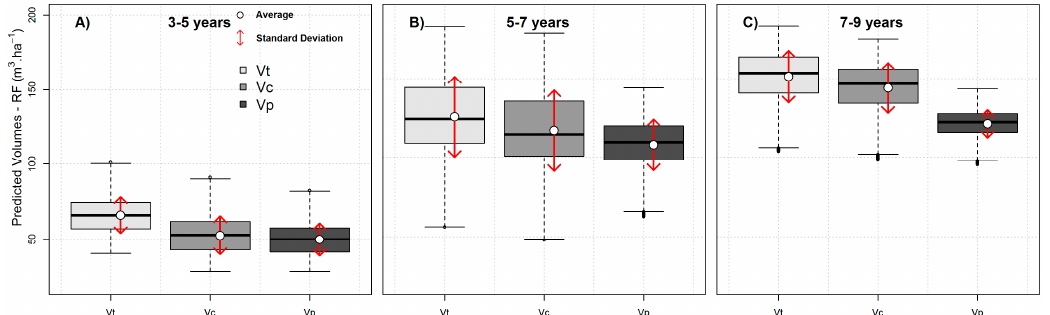
Figure 6. Predicted Vt, Vc and Vp of P. taeda at stand-level for the studied stands. ( A ) 3–5 years; ( B ) 5–7 years and ( C ) 7–9 years. The thick line in the box indicates the median value of the predicted stem volume. Boxes extend from the 25th to the 75th percentile, whiskers extend 1.5 times the length of the interquartile range above and below the 75th and 25th percentiles. The white dote is the mean of the predicted stem volume, and the vertical read lines represents the standard deviation around the mean (Mean ± SD).